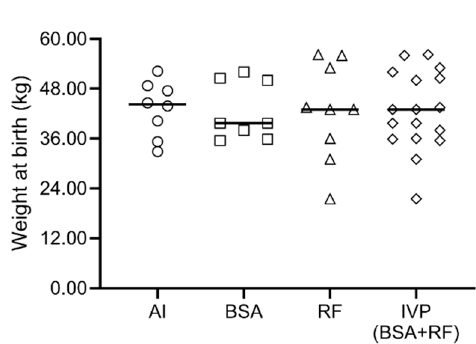
Figure 3. Weight at birth of calves born through artificial Insemination (AI) group, bovine serum albumin group (BSA), reproductive fluids group (RF) or in vitro-produced (IVP, corresponding of BSA + RF). The line represents the median and each symbol represents one animal.